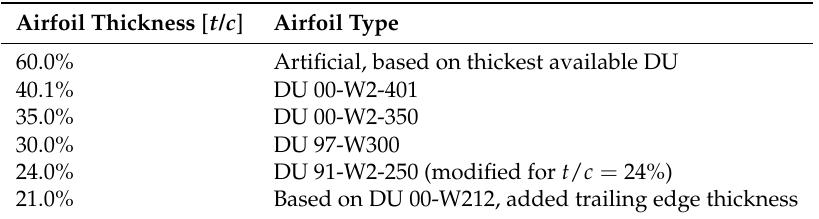
Table 1. Airfoil sections used for the AVATAR reference blade